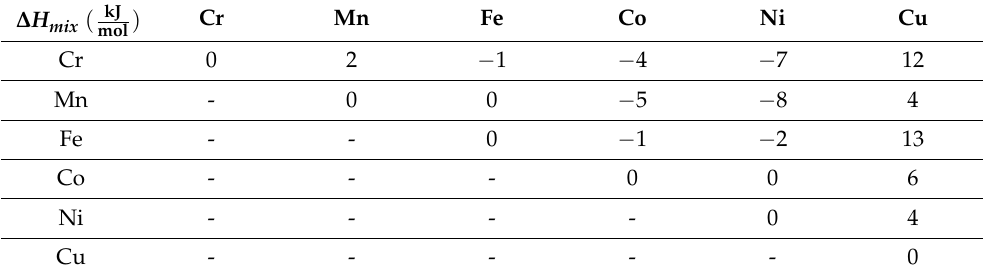
Table 5. Values of mixing enthalpy calculated by Miedem’s model of binary atomic pairs between all constituent elements. Taken from Ref. [29].